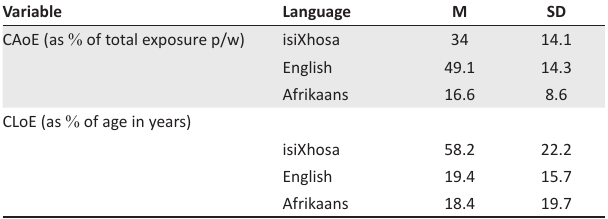
TABLE 1: Trilingual group’s ( n = 11) language exposure data, as